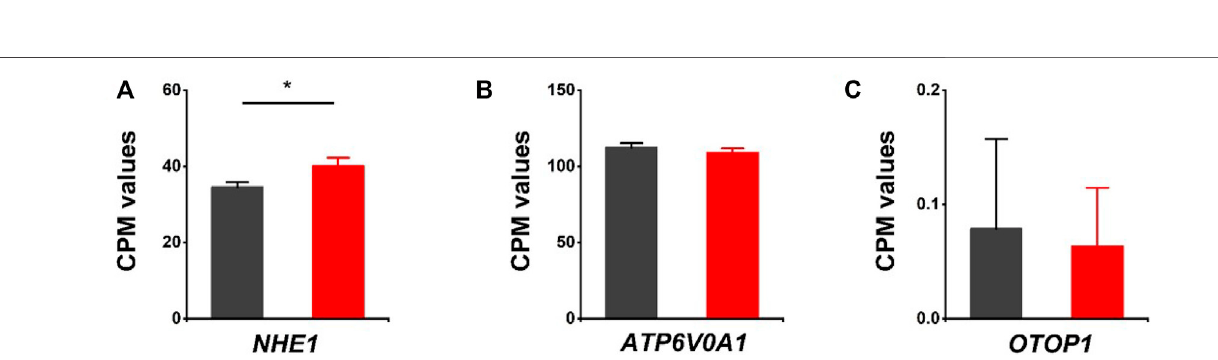
Frontiers in Cell and Developmental Biology |